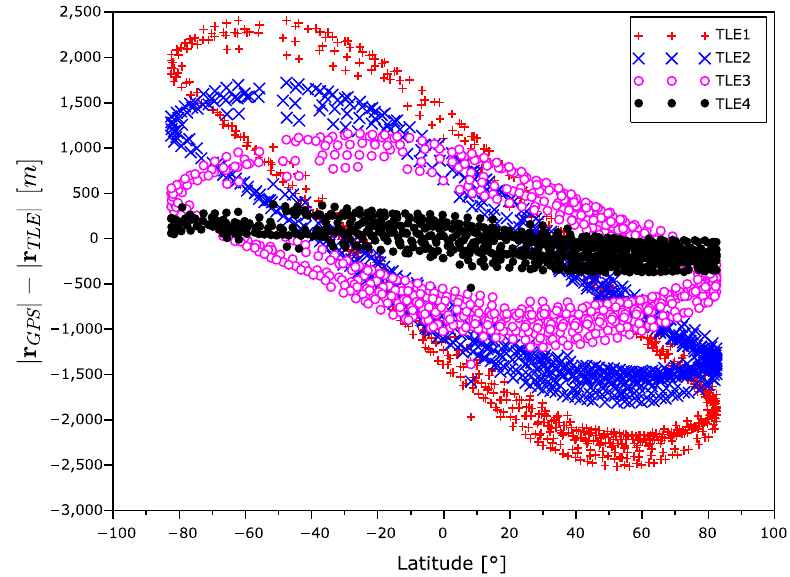
Figure 12. Radius error as a function of latitude.